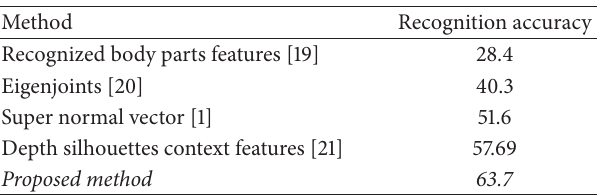
Table 1: Comparison of recognition accuracy using IM- DailyDepthActivity.